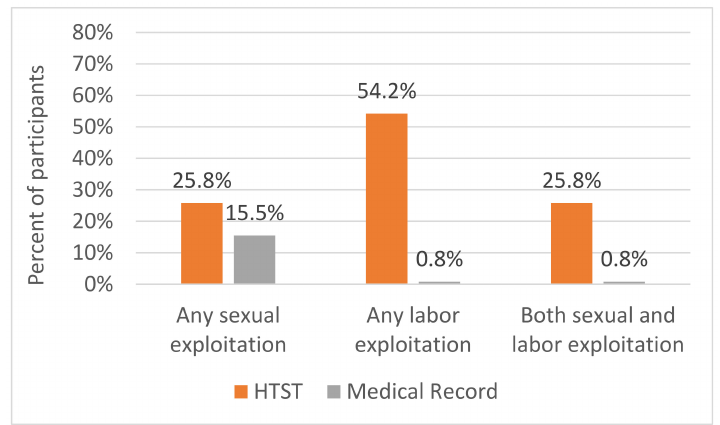
Figure 1. Identification of sexual and labor exploitation using the Human Trafficking Screening Tool (HTST) versus medical